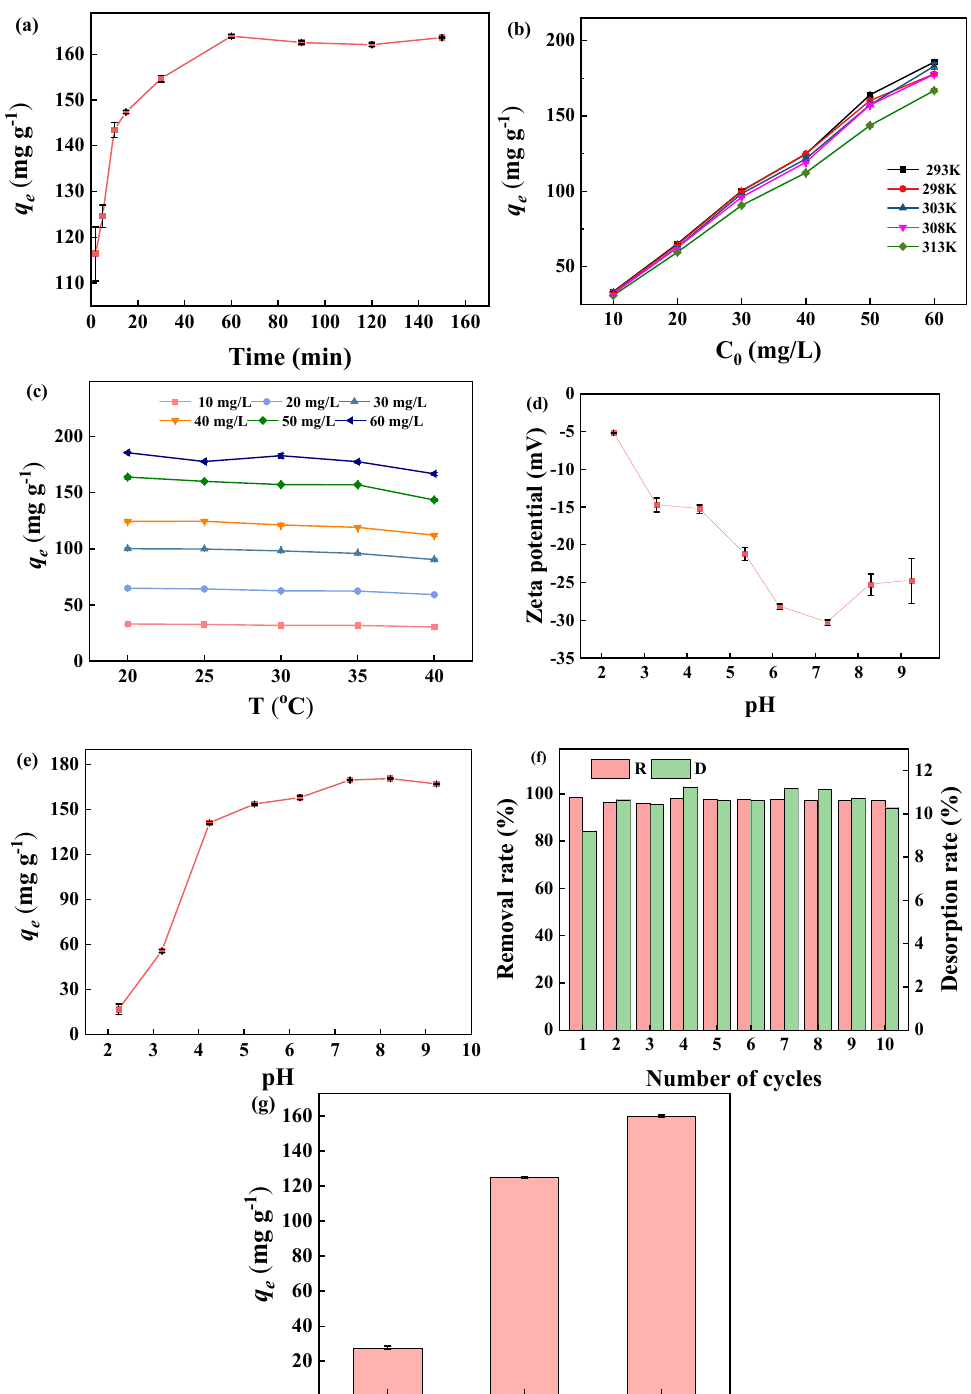
Figure 5. Adsorption properties of BJ160 for MB: ( a ) e ff ect of contact time ( C 0 = 50.0 mg L − 1 , T = 25 °C); ( b ) e ff ects of initial MB concentration ( t = 60 min); ( c ) e ff ect of contact temperature (t = 60 min); ( d ) e ff ect of initial solution pH value ( C 0 = 50.0 mg L − 1 , t = 60 min, T = 25 °C); ( e ) zeta potential of BJ160 in aqueous solution at di ff erent pH values; ( f ) reusability of BJ160 for removal of MB in ten successive adsorption-desorption cycles ( C MB = 50 mg L − 1 , adsorbent dosage of 50.0 mg, and contact time of 60 min, T = 25 °C). ( g ) Adsorption capacity of BJ160 toward di ff erent dyes in aqueous solu- tions (dye concentration = 50 mg L − 1 , adsorbent dosage = 5.0 mg, t = 60 min, T = 25 °C).